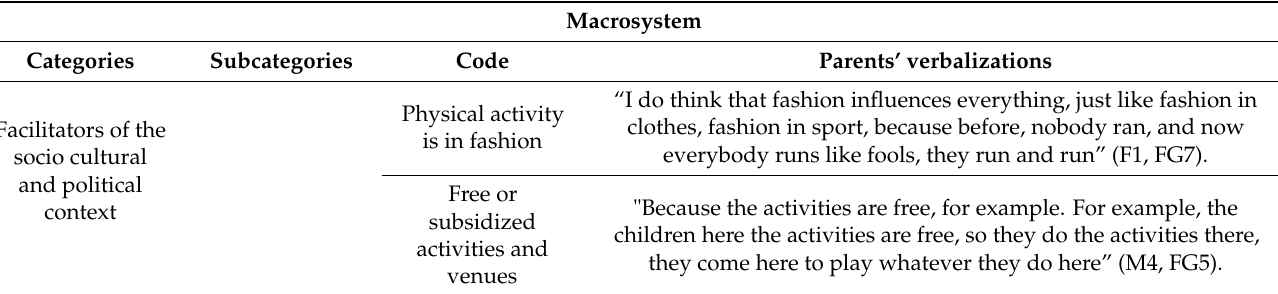
Table 12. Macrosystem facilitators for physical activity among